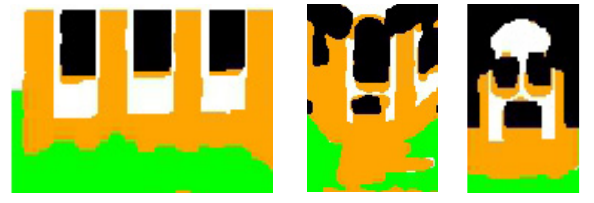
Figure 7. Enhanced façade plots. All three facades are corrected for the position of the plane (distance to the camera) and enhanced